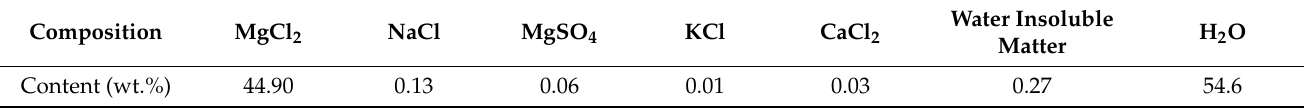
Table 1. Chemical composition of